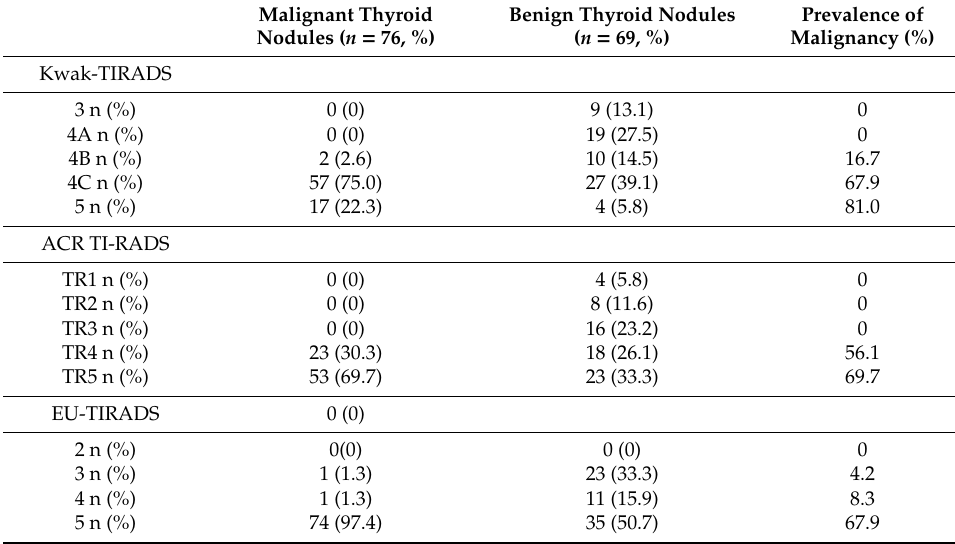
Table 2. Distribution of malignant and benign thyroid nodules for all tested variants of Thyroid Imaging Reporting and Data Systems (TIRADS) classifications.